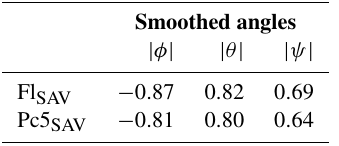
Table 3. Correlation coefficients between the smoothed angles of the main semiannual hypotheses ( | φ | , | θ | and | ψ | ) and the observa- tional curves (Pc5 SAV and FL SAV ).